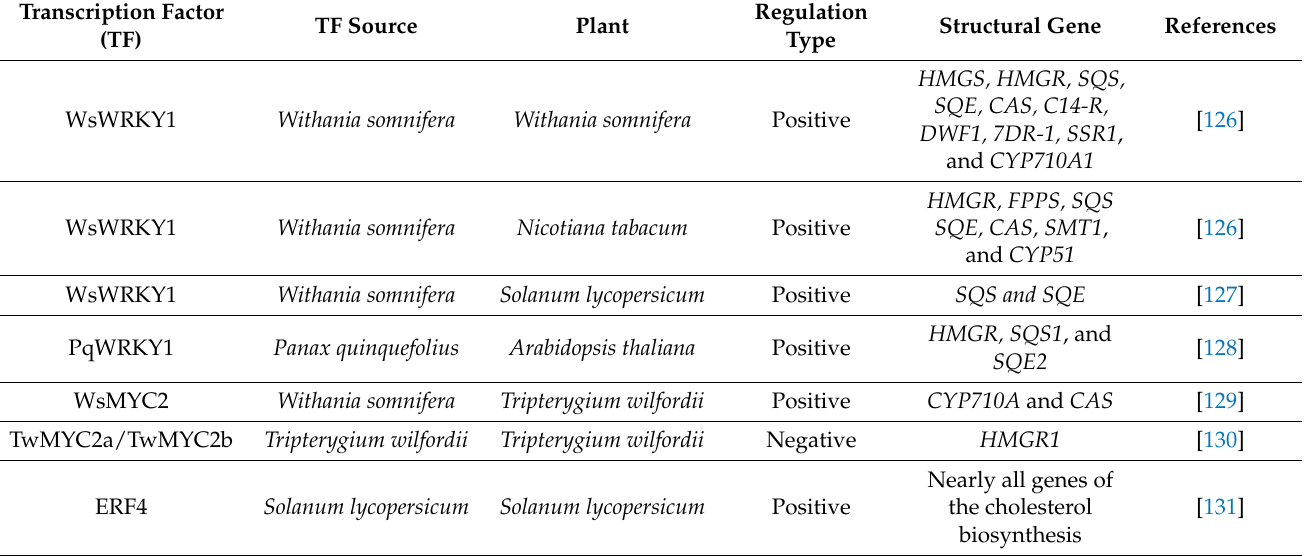
Table 2. The regulation of the transcription factors to the plant sterols synthesis in